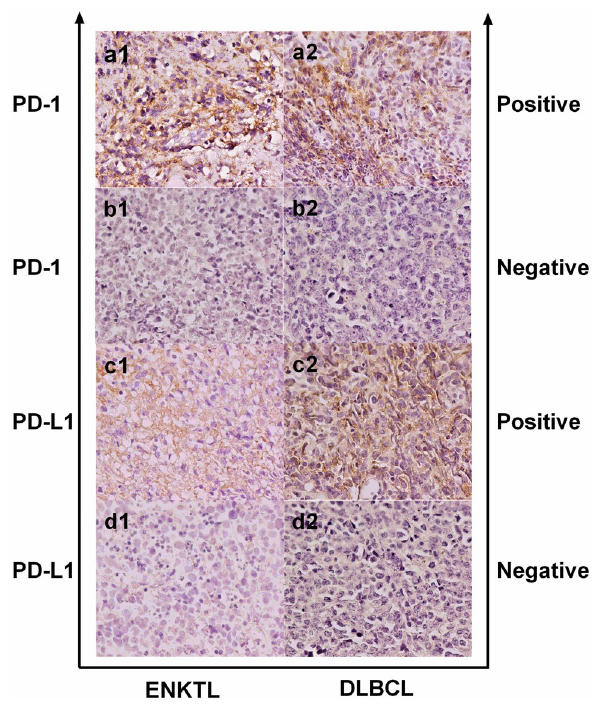
Figure 1. Immunohistochemical staining of PD-1 (a1,a2,b1,b2) and PD-L1 (c1,c2, d1,d2) under the microscope of ENKTL and DLBCL.